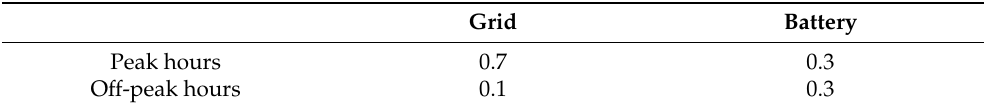
Table 1. Price per kWh for grid and battery.